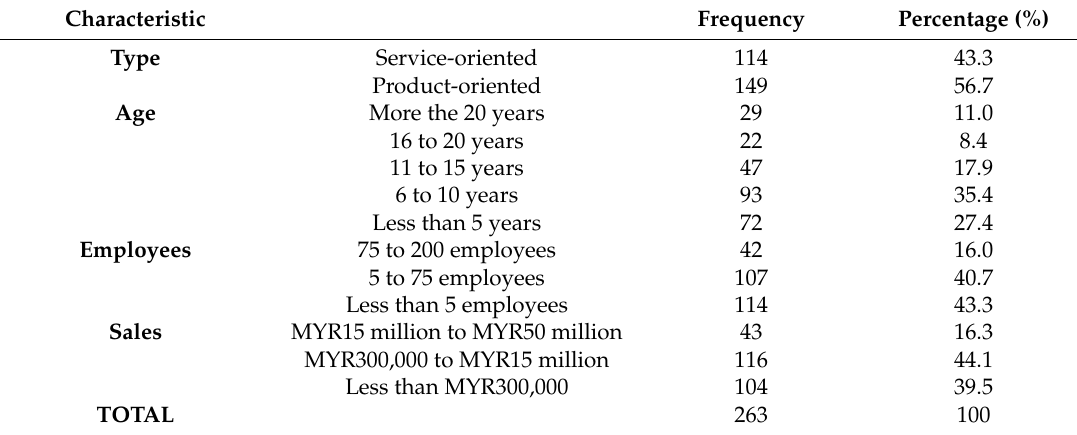
Table 1. Respondents’ Demographic